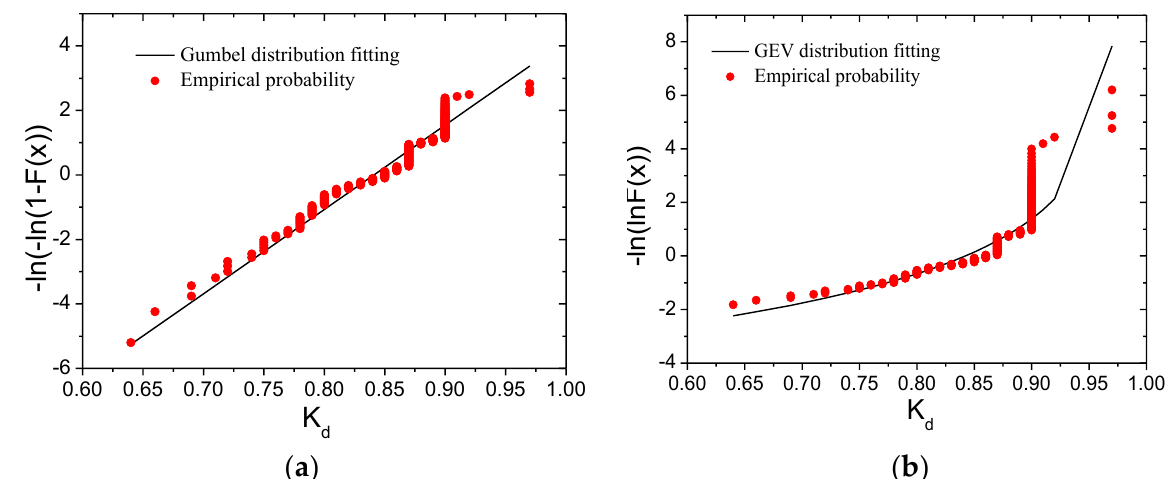
Figure 17. Fitting results of the probability distribution of K d value. ( a ) Gumbel probability distribution fitting, ( b ) GEV probability distribution fitting.